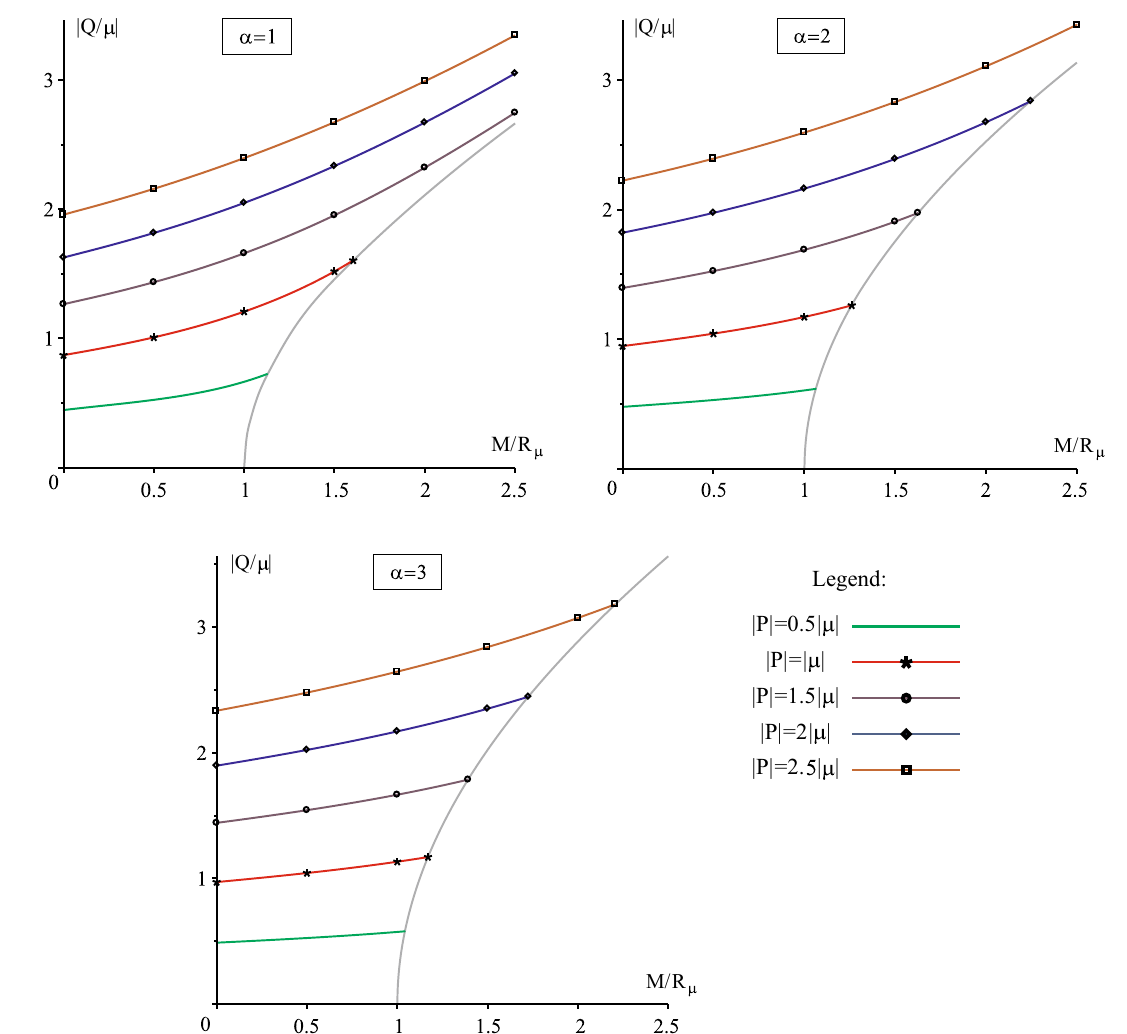
sponds to the limiting case P (cid:15) μ . Lines on the panel correspond to | P | = 0 . 5 n | μ | , where n = 1 ,..., 5. The gray line defines the mass– charge relation for the spacetime metric with double (extremal)